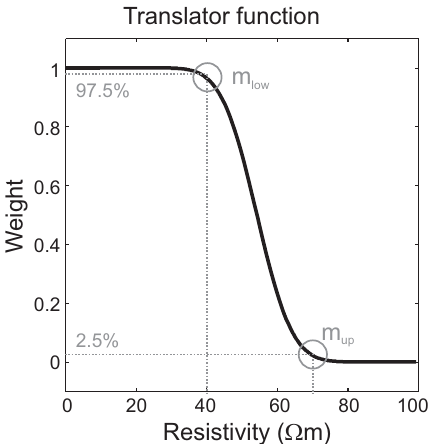
Figure 4. The translator function is the petrophysical relationship used in the CF inversion. The parameters m low and m up are varied to move the translator function along the resistivity